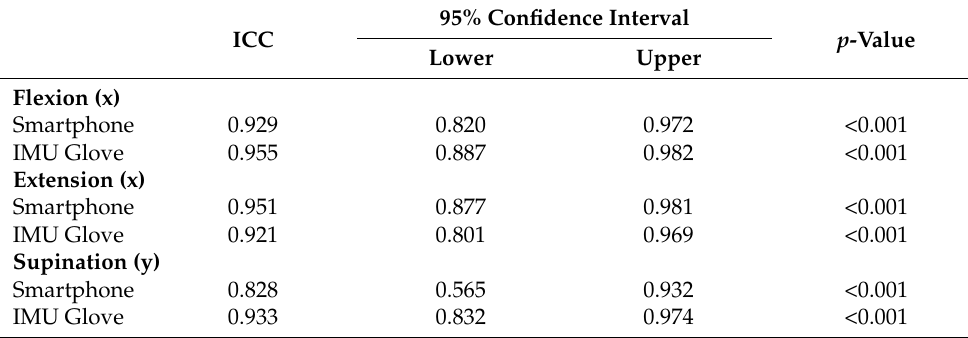
Table 2. Intraclass correlation coefficient of a smartphone device and the proposed IMU glove with standard goniometer as the gold